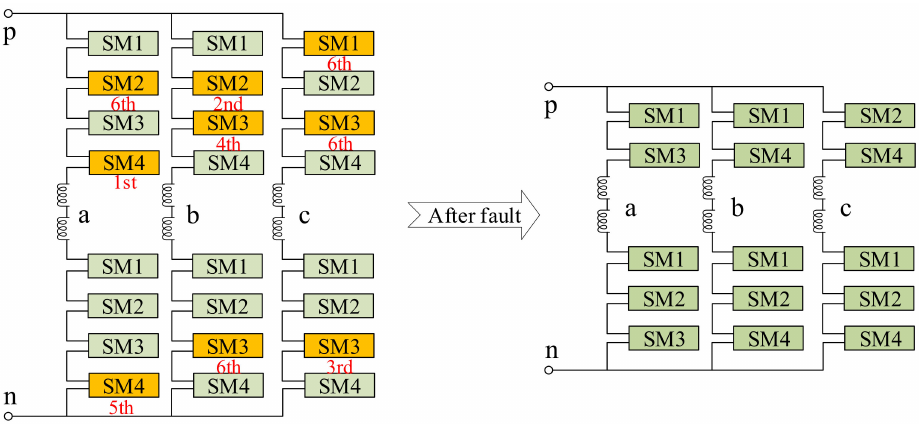
Figure 9. The sequence of SM faults and the post-fault equivalent